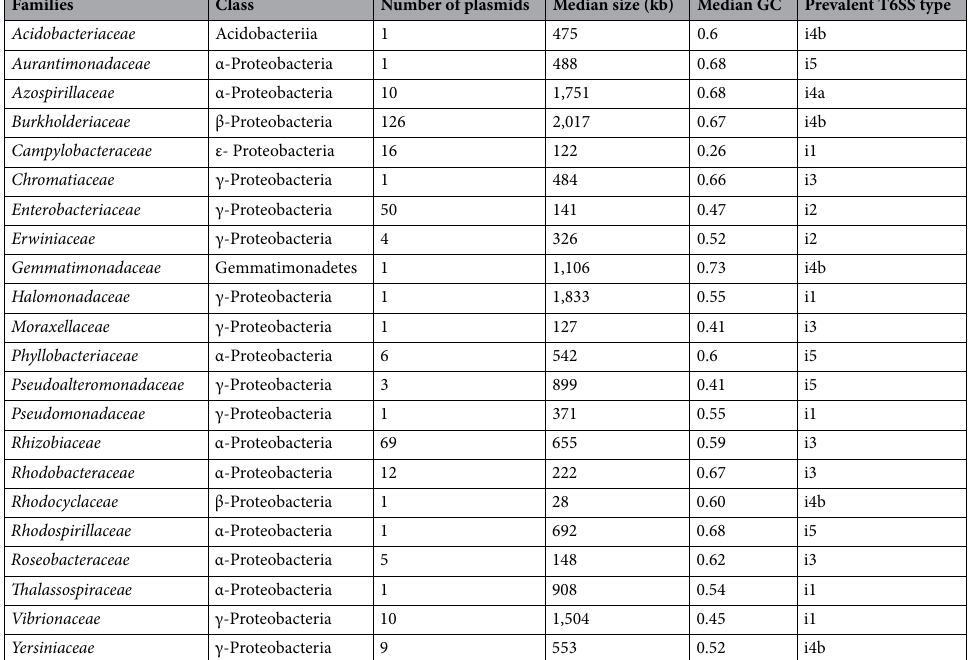
Table 1. Features of T6SS-carrying plasmids.